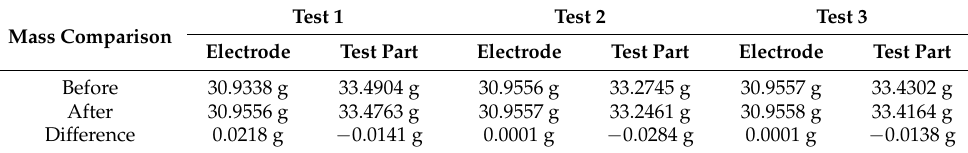
Table 6. Difference between test parts and shell masses. Average values.